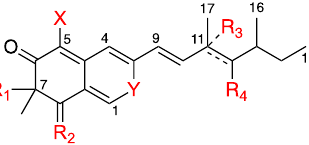
Figure 2. R 1 can possess acylation of different sizes or form a lactone ring with R 2 . Y can be O, NH or N-alkylation, R 3 and R 4 can form an alcene until C-11 and C-12 or an epoxyde or are hydroxyles, and X can form either a hydrogen or a chlorine atom. These modifications can be combined.